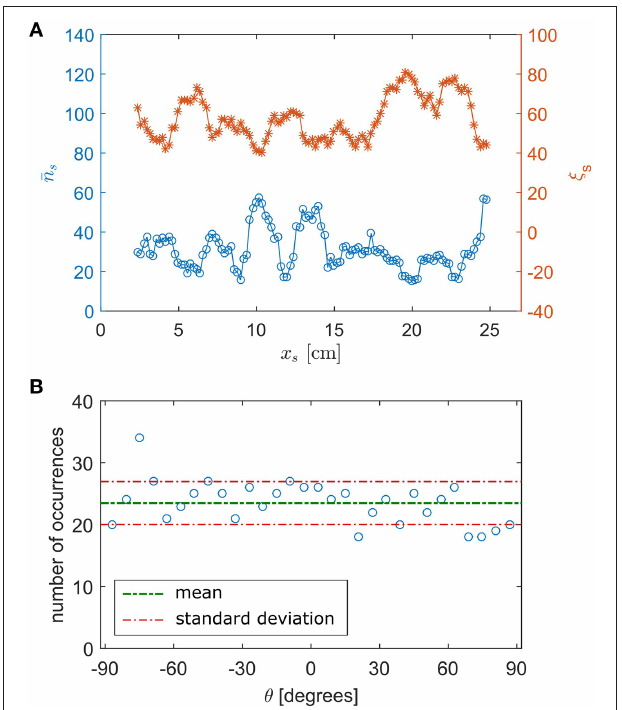
FIGURE 7 | Typical pressure signal signatures for experiments performed under different boundary conditions. The signals are formed by a sequence of n s (bottom curve, left scale) and number of FIGURE 6 | (A) Average burst size pulses, each formed by one drop and one relaxation phase. During the drop ¯ bursts ξ s (top curve, right scale) inside sliding subwindows centered at x s (see phase one or several pores are invaded. During the relaxation phase the Figure 5 ). The sliding subwindow spans the whole width of the system and capillary pressure increases again as the menisci readjust themselves inside has a fixed length of 2 cm. The spatial distribution of bursts follows no the pore-throats, see arrows. (A) For the CWR boundary conditions, the signal n s is computed by systematic trend along the model. The average burst size presents a quasi-linear relaxation behavior. The pressure pulses themselves ¯ dividing the burst area by typical pore area 3 mm. (B) Histogram showing are seen in the larger scale, while menisci readjustments and the white noise ≈ the random orientation of the bursts shown in Figure 5 . The thicker green line from the sensor are shown in the respective insets. (B) For the CIP boundary shows the mean of the distribution and the thinner red lines show its standard condition, the pulses happen in an intermittent fashion. Long intervals of deviation. inactivity are punctuated by sudden events and the relaxation behavior has an exponential signature in which the capillary pressure relaxes back to the level imposed by the external liquid reservoir. A pressure pulse can trigger others and even give rise to a large avalanche composed of multiple